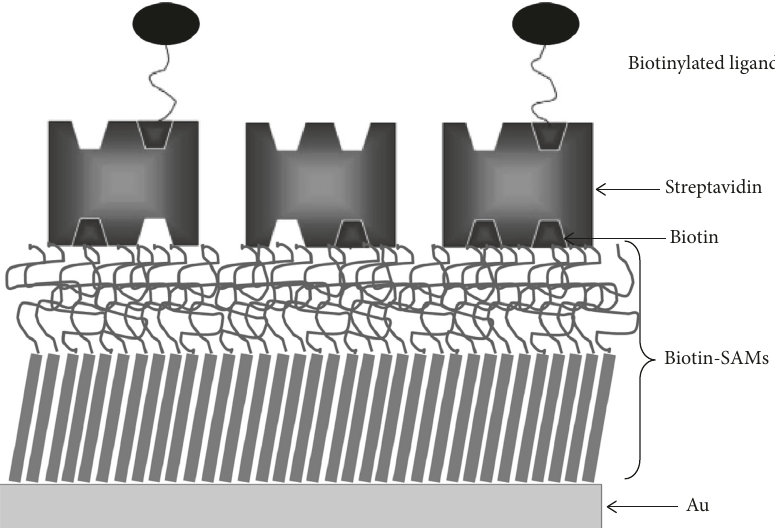
Figure 4: Schematic representation of mixed SAMs prepared with biotinylated alkanethiol (BAT) and triethylene glycol alkanelthiol (EG3) followed by streptavidin adsorption and ligand immobilization (not scale). Adapted from Freitas et al.